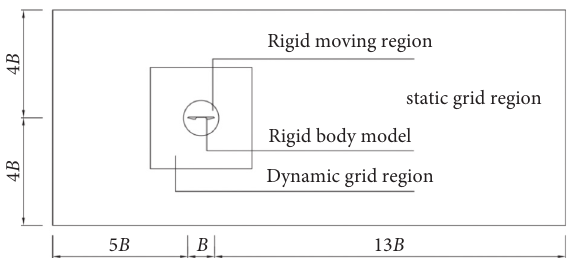
Figure 2: Schematic diagram of model computing domain ( B is the width of deck section).